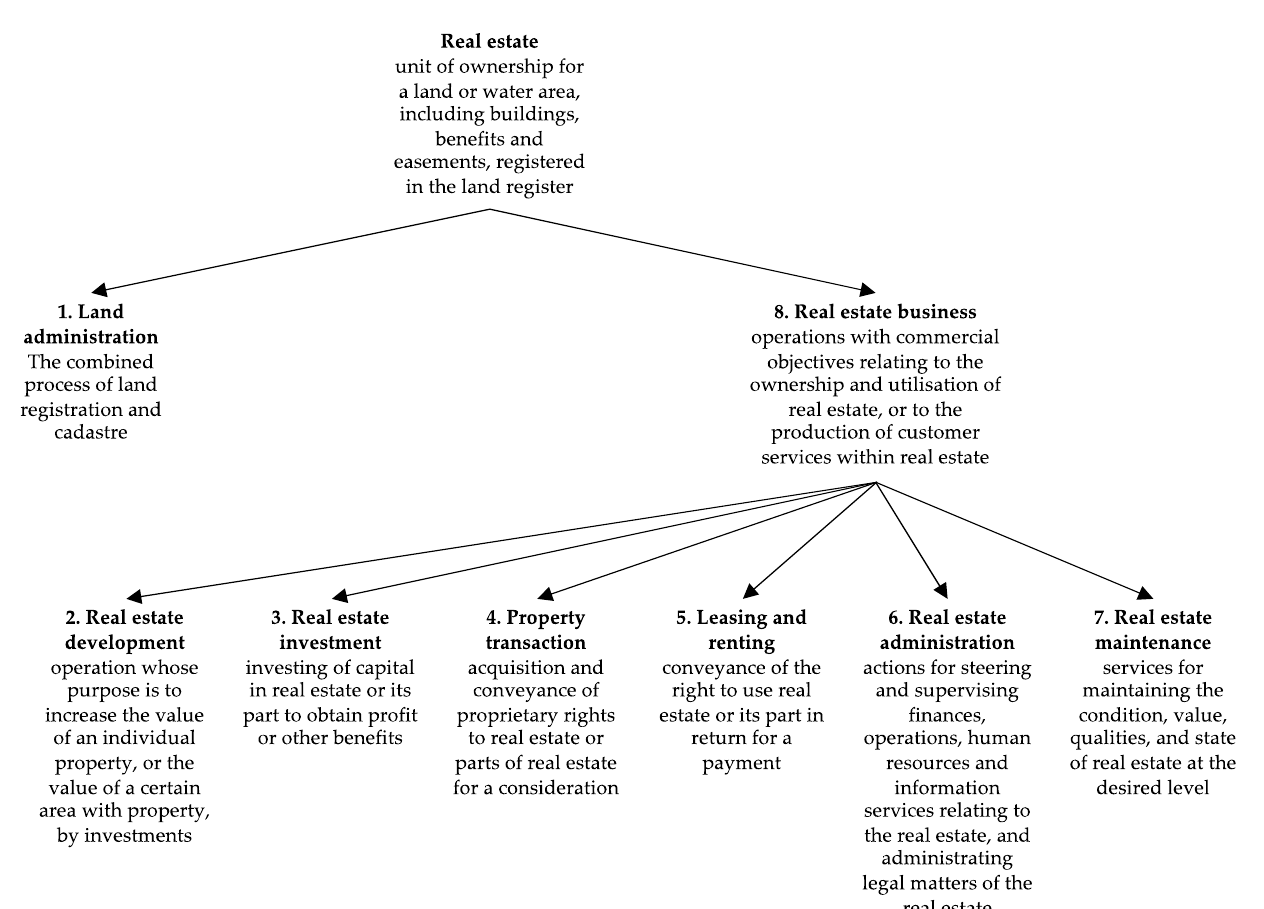
Figure 1. The conceptual schema of the real estate subsectors used in categorizing the blockchain literature with real estate merits. Adapted with permission from Ref. [4]. 2012, The Finnish Terminology Center and from Ref. [24].